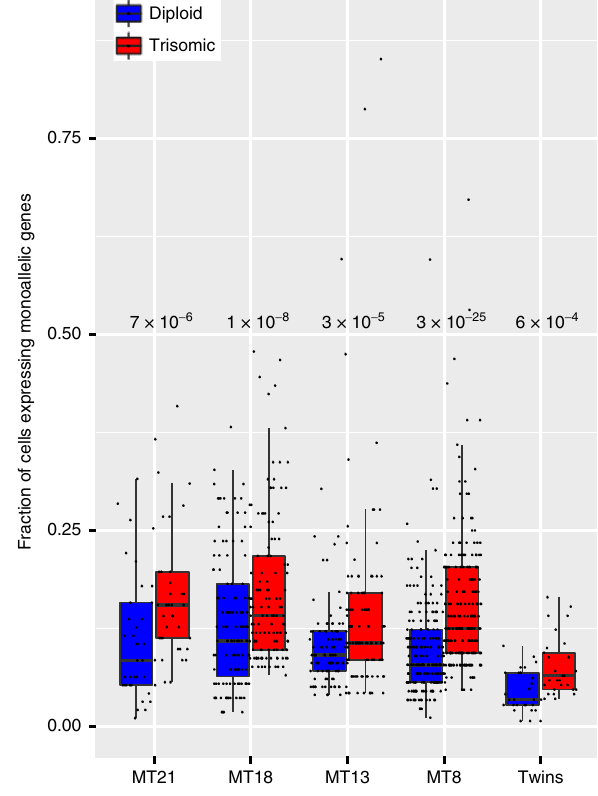
Fig. 5 Higher fraction of expressed cells for supernumerary chromosome genes. In all trisomies an increased fraction of single trisomic cells expressing supernumerary monoallelic genes is detectable. P -values in the fi gure indicate the respective statistical signi fi cance of the comparisons between diploid and trisomic cells. Blue — fraction of diploid single cells. Red — fraction of trisomic single cells. Boxplot: horizontal lines indicate medians; upper and lower boxes indicate fi rst (25th percentile) and third quartiles (75th percentile); whiskers indicate fi rst quartile — 1.5 IQR (interquantile range = fi rst – third quartile) and third quartile + 1.5 IQR. MT = Mosaic Trisomy. Source data are provided as Source Data fi